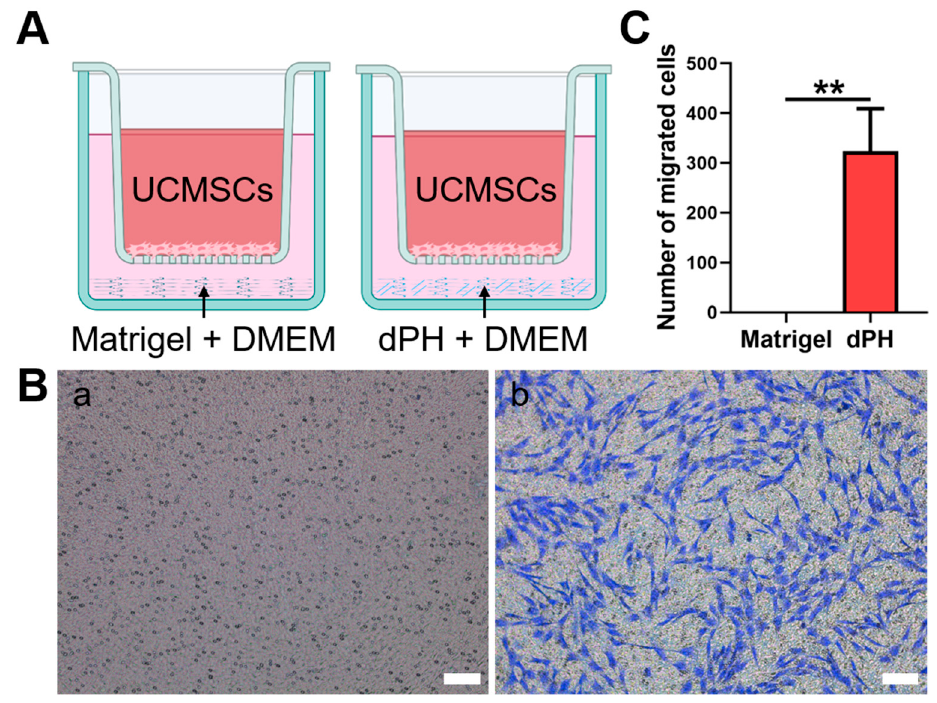
Figure 5. The chemotactic assay of Matrigel and dPH. ( A ) A schematic illustration of the assay. ( B ) HUCMSCs migrated through the upper chamber membranes of Transwell to Matrigel (a) and dPH (b) after 12 h. ( C ) Number of migrated cells in dPH and Matrigel. Scare bar = 100 μ m. ** p < 0.01.